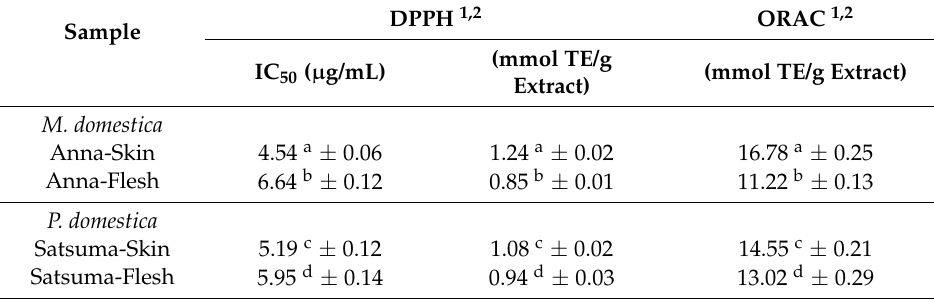
Table 3. DPPH and ORAC antioxidant